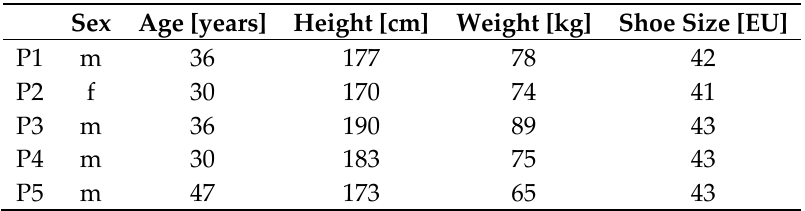
Table 1. Participant characteristics.